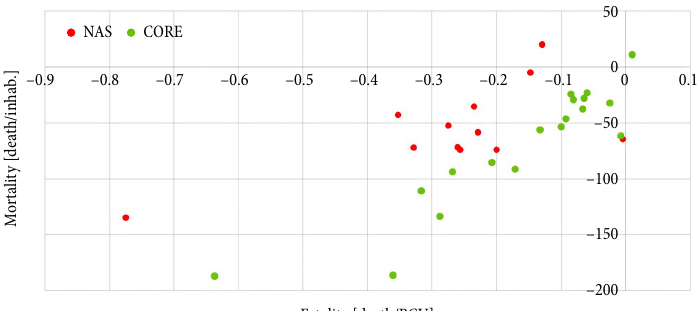
Fig. 4. Statistical development of mortality and fatality rates (please note that only 2000, 2005 and 2009 were visualized in order to keep the resolution of figure)